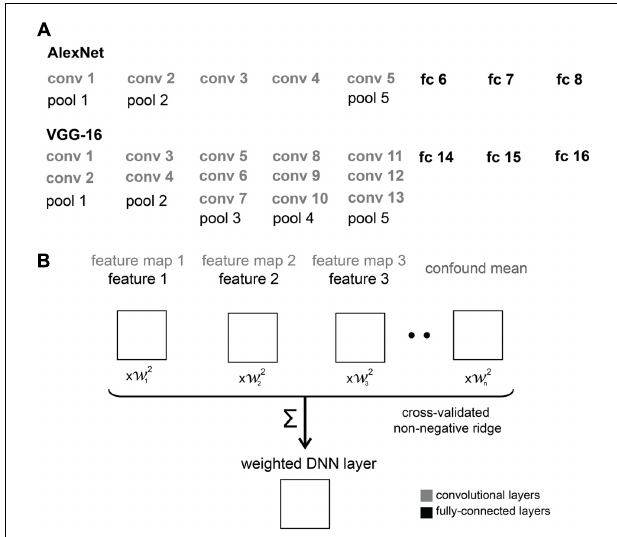
FIGURE 2 | DNN architectures and feature weighting. (A) Comparison of AlexNet and VGG-16 architectures. We used convolutional (conv) and fully-connected (fc) layers from AlexNet and VGG-16 in our analyses. (B) Schematic overview of feature weighting. The schematic shows a set of example RDMs characterizing the stimulus information represented by the DNNs. For convolutional layers, we created RDMs from activations of feature maps. For fully-connected layers, we created RDMs from activations of individual features, i.e., model units. Within each DNN layer, we used regularized (non-negative ridge) linear regression to estimate the RDM weights that best predict the similarity-judgment RDM. Each DNN layer includes a confound-mean predictor (intercept). The weights were estimated using a cross-validation procedure to prevent overfitting to a particular set of images.